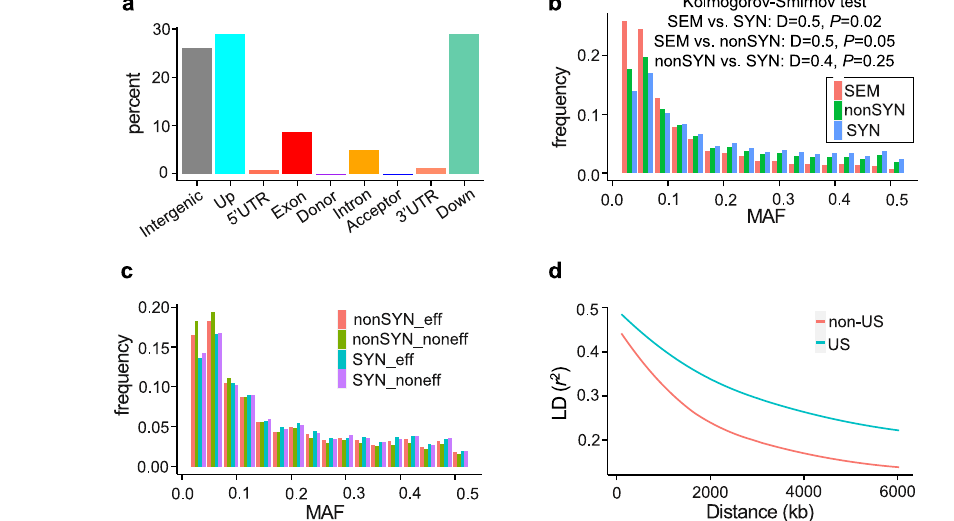
MAFspectrabetweenthesetwotypesofSNPs.SEMstrongeffectmutationsinclude stop codon gain and splice site disruption. c MAF of synonymous and nonsynon- ymous SNPslocatedwithinpredicted effectors and non-effectors. d The rate of LD decayinthePgtsamplesfromtheUS(15isolates)andoutsideoftheUS(22isolates) was modeled as a function of the physical distance between